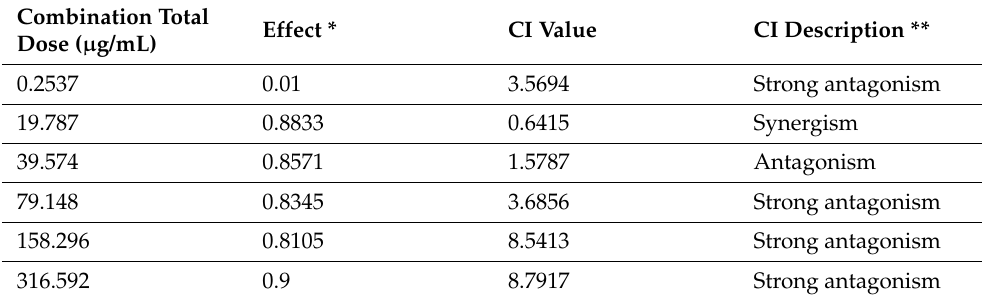
Figure 3. Dose–effect curve and median effect plot of the combination experiment in SKOV3 cells. Using dose and effect data obtained from the MTT assay, the CompuSyn software was used to plot the dose–effect curve ( A ); as a prerequisite for determining synergism or antagonism, the dose effect curve is utilized to determine the potency of each drug individually along with the drug combination. The dose–effect plots can be better visualized by linearization in the median effect plot ( B ); the antilog of the x-intercept of the median effect plot gives the median effect dose (Dm) which signifies the potency of each drug (the dose that results in 50% effect). By the law of mass action, the Dm is used to determine the combination index (CI) values. S. triloba (ST); paclitaxel (PTX); S. triloba + paclitaxel (ST-PTX); fraction of cells inhibited by treatment (Fa); fraction of cells uninhibited by treatment (Fu); dose (D). Table 5. Summary of combination index (CI) values for SKOV3 cells.